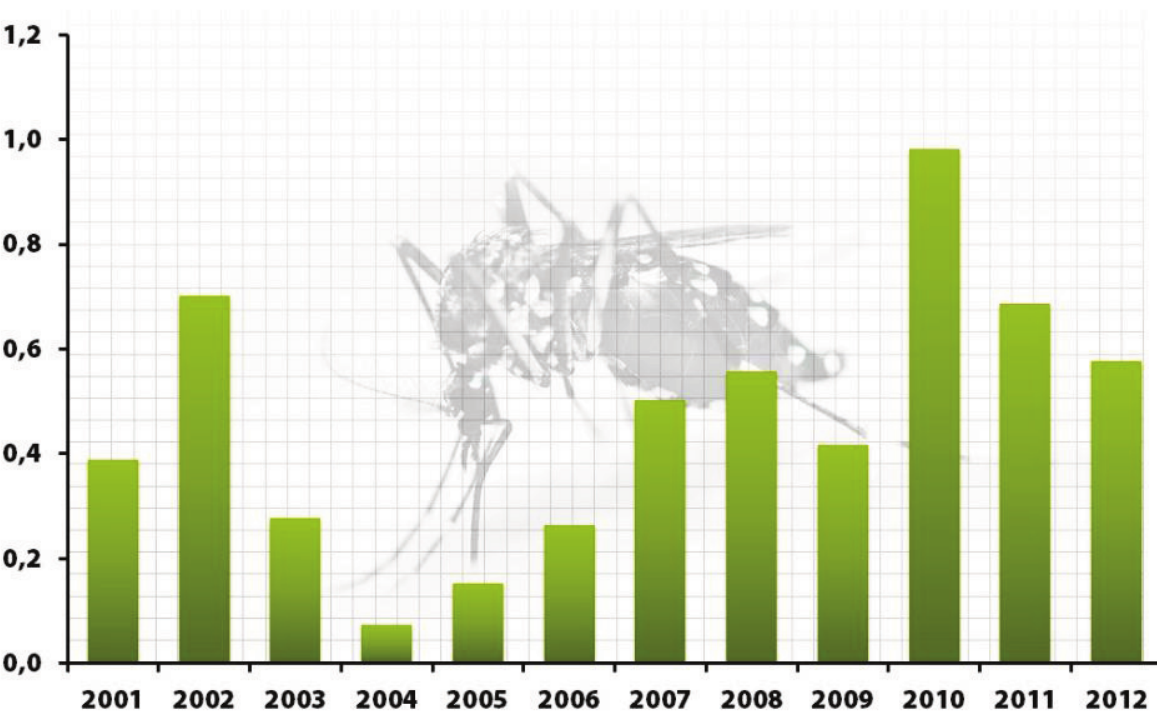
Figure 1. Number of dengue cases in Brazil. Source: Notifiable Diseases Information System